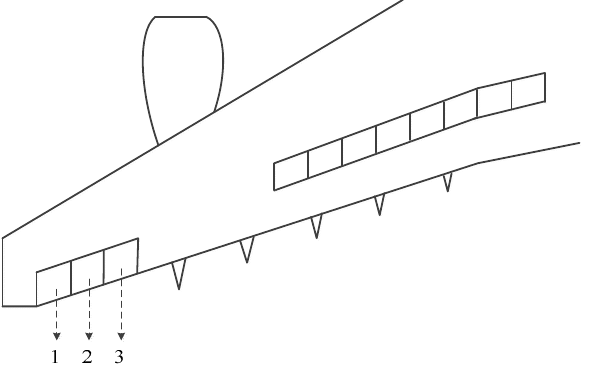
Figure 1. Primary flight control surfaces layout.